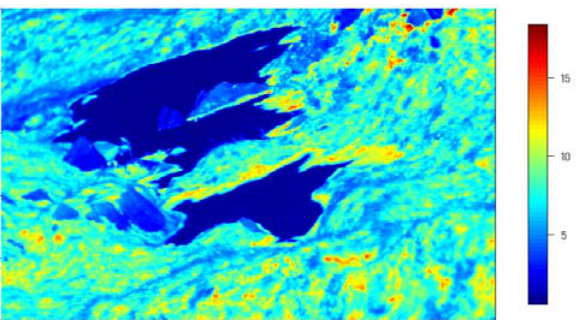
Figure 3: Standard deviation of radiation temperature [°C] measured at a snow patch during a period of 4 h in 5 min intervals.